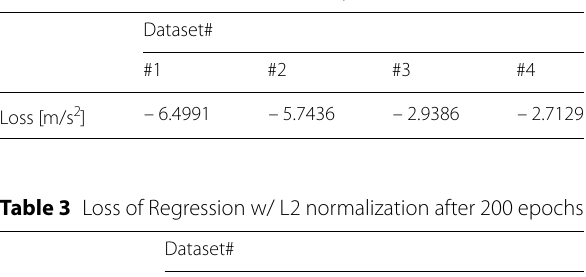
Table 2 Loss of MLE (ours) after 200 epochs